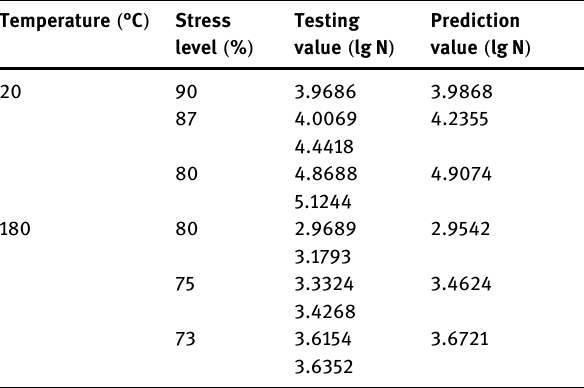
Table 7: Comparison of the predicted and experimental values